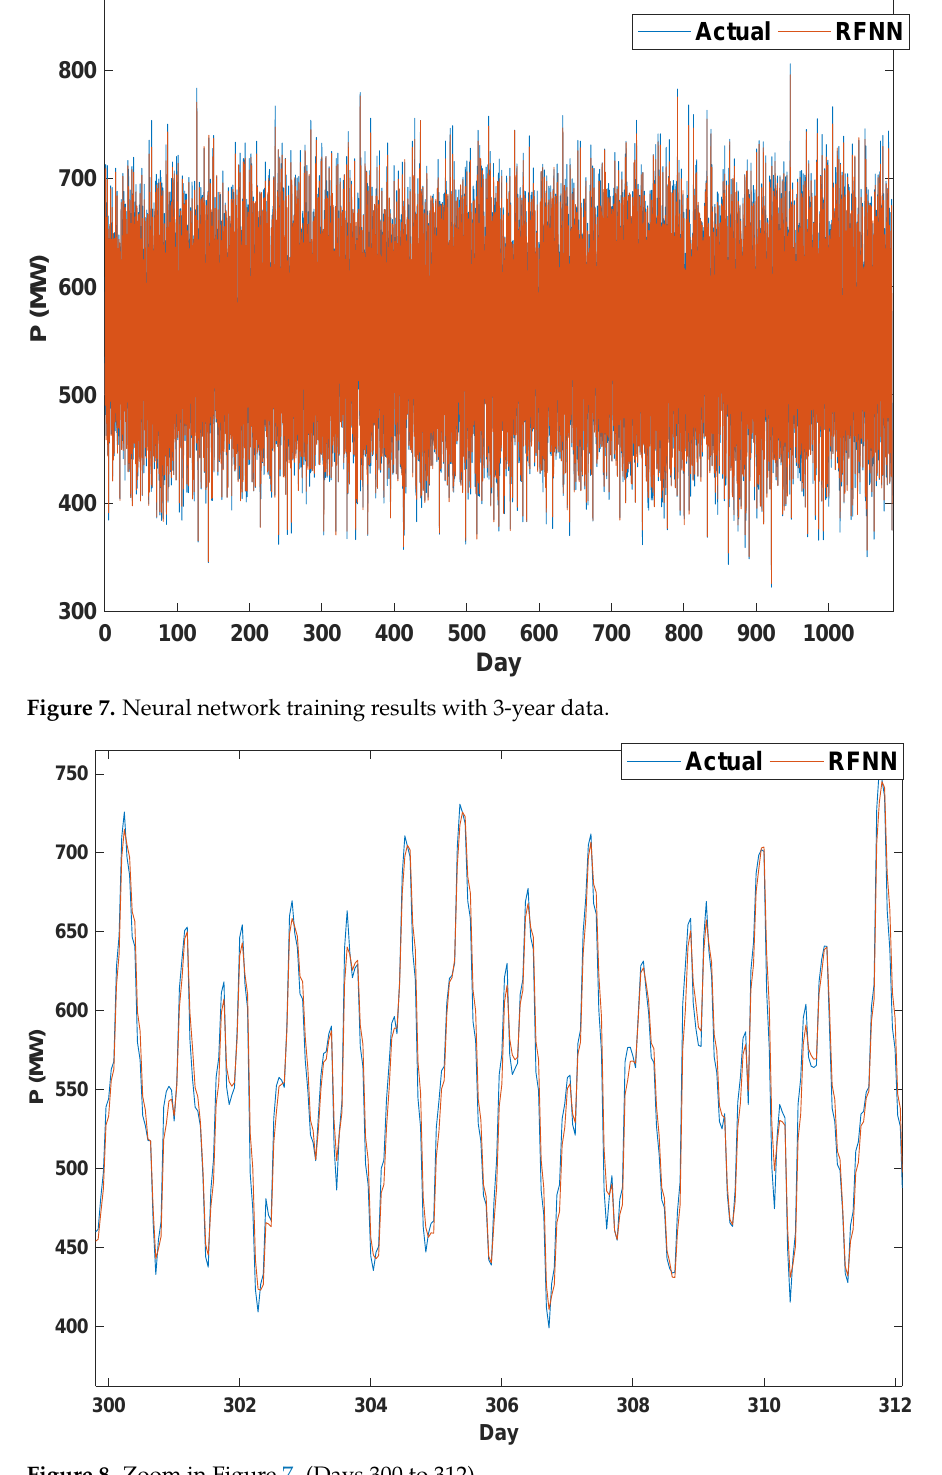
Figure 8. Zoom in Figure 7. (Days 300 to